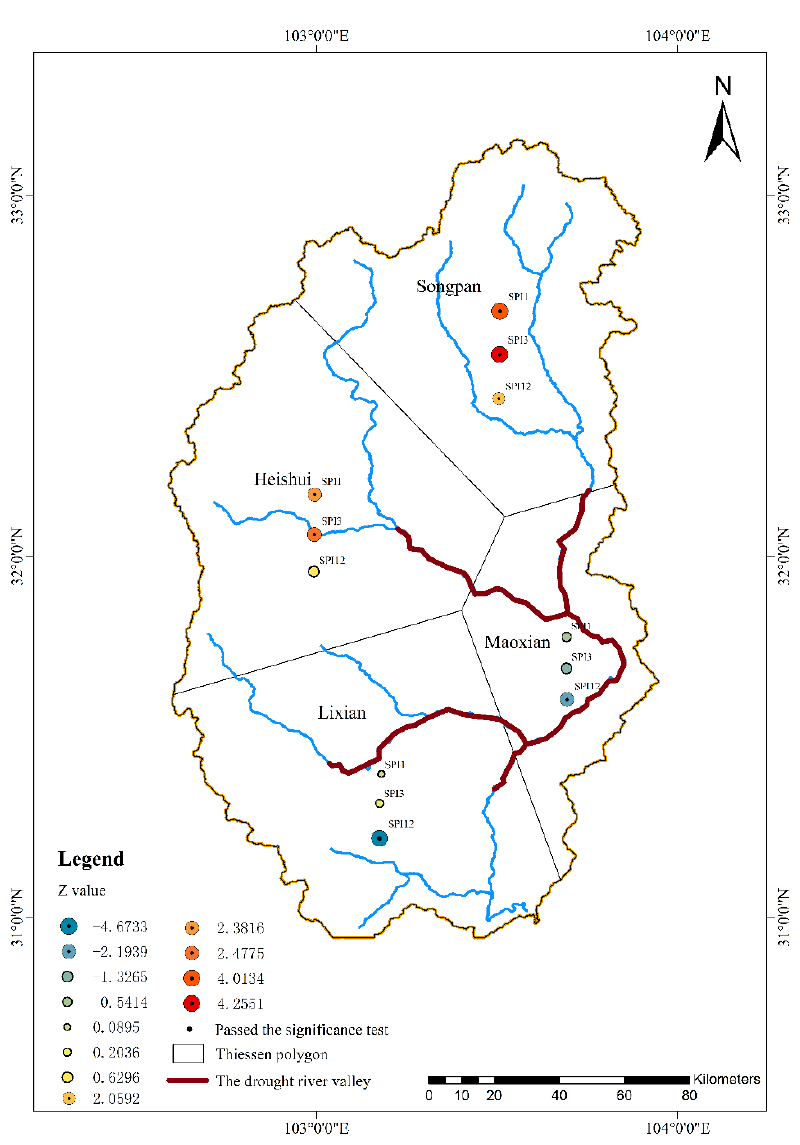
Figure 2. Spatial distribution of variation trends of SPI1, SPI3 and SPI12 (unit: month).